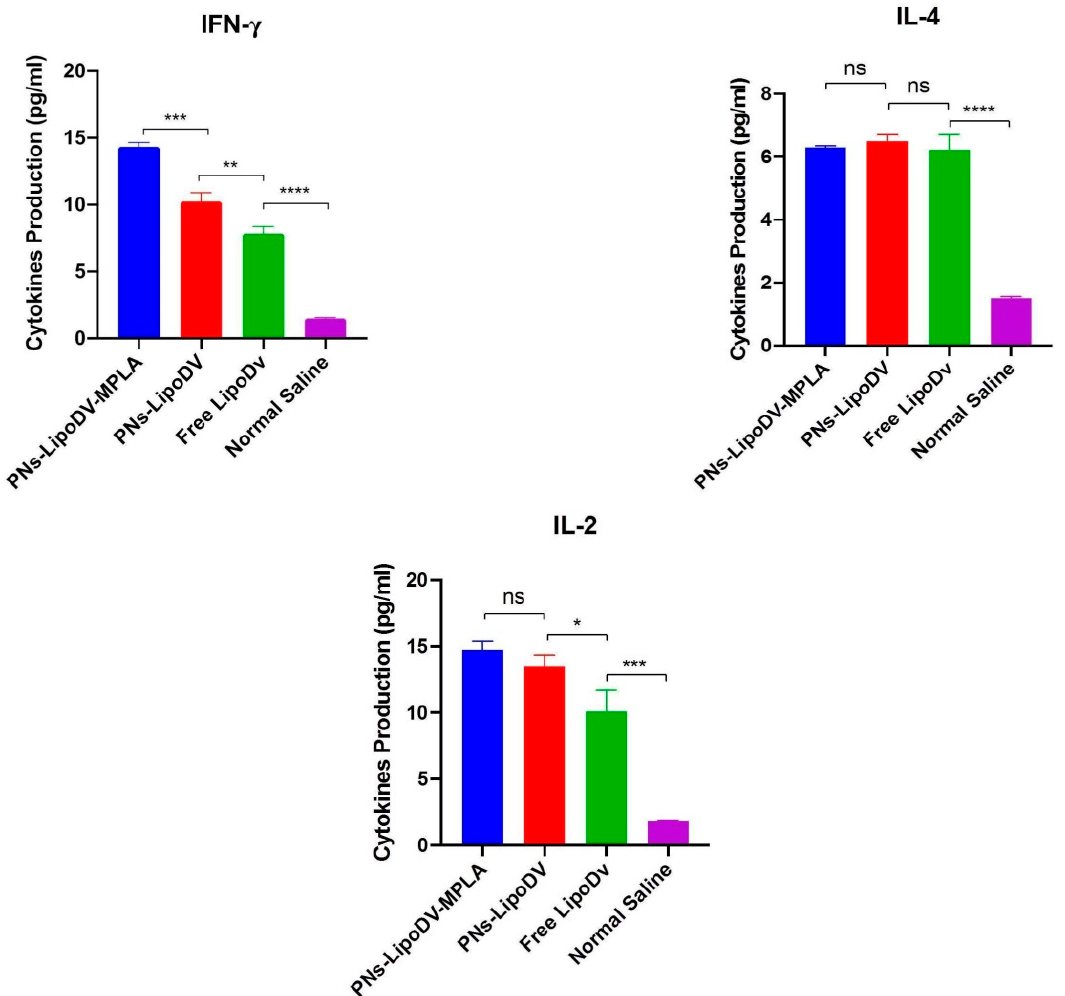
Figure 6. Splenocytes cytokines (IFN- γ , IL-2 and IL-4) response to immunization with vaccine candidates. Bars represent mean concentrations ± standard deviations. The level of cytokine secretions among the tested groups were compared using one-way ANOVA, followed by post hoc test (Tukey) (ns, p > 0.05; * p < 0.05; ** p < 0.01; *** p < 0.001; **** p < 0.0001).